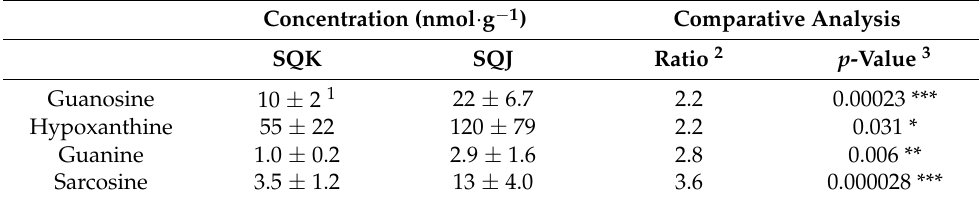
Table 1. Concentrations of other